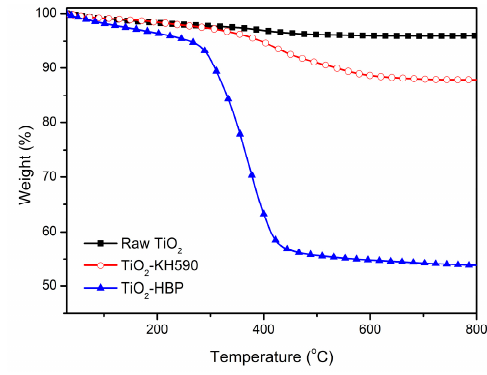
Figure 7. Thermogravimetry analysis (TGA) curves of raw TiO 2 , TiO 2 -KH590, and TiO 2 -HBP.